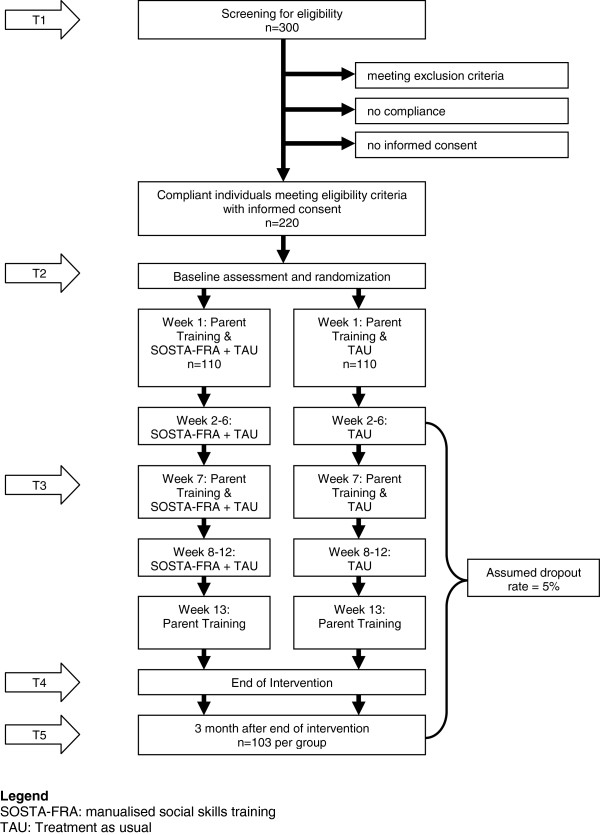
Trial Time Flow.